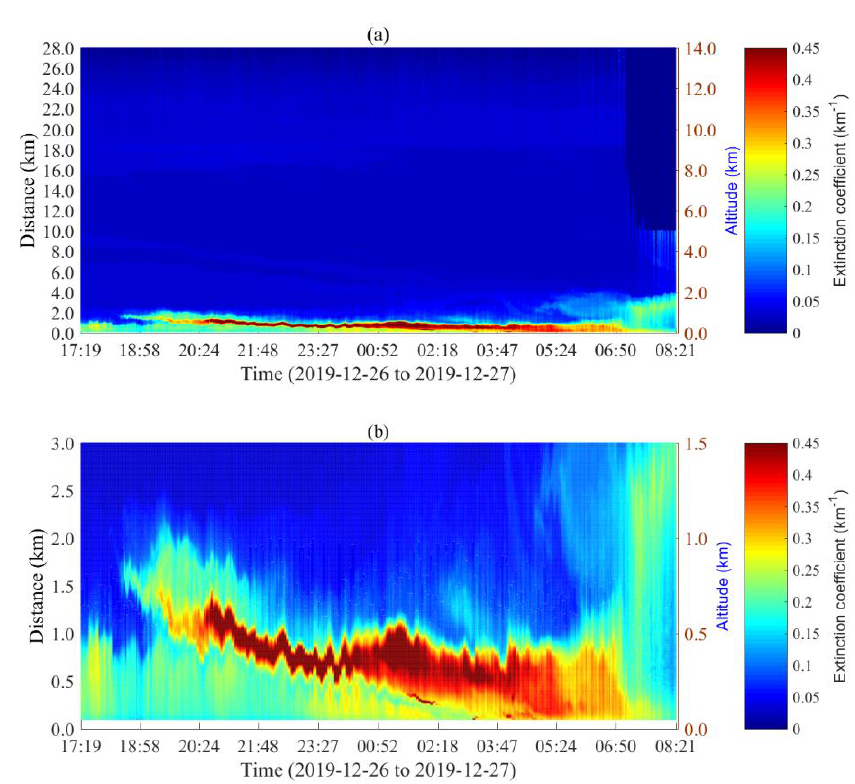
Figure 12. ( a ) Time-spatial variation of the atmospheric aerosol extinction coefficient from the near ground up to 28 km (14 km in altitude), and ( b ) zoom in of the aerosol extinction coefficient within 3 km distance (1.5 km in altitude).